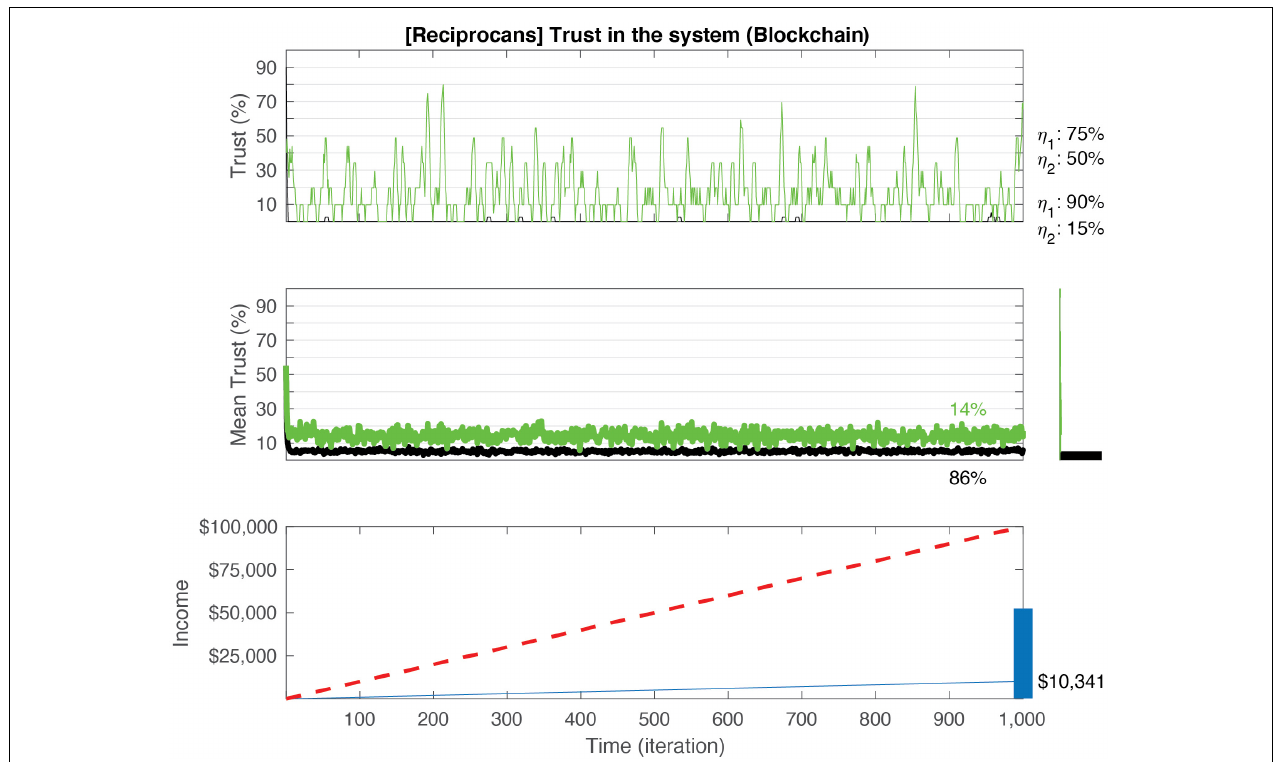
FIGURE 5 | Simulation of reciprocans Blockchain games with varying values of η 1 and η 2 . Top: depiction of two examples of games with η 1 >> η 2 and η 1 ≈ η 2 ratios. Middle: trust (see equation 2) decays in 86% of games to a value lower than the mean (7%), irrespective of the initial trust and the ratio between η 1 and η 2 (black line in the middle/top panels). Green (/black) line corresponds to the average of all trials that ended with trust values above (/below) the mean. A histogram of all final trust values is shown to the right. While high trust values have broader range, convergence to 0 trust is still dominant. This, however, has no effect on the individual/C-3PO income. Bottom: Blue line corresponds to the average cumulative sum in the games. The total cumulative sum generated by the C-3PO is $10,341. Red dashed line depicts the optimal (“Full trust”) revenue that the C-3PO can generate if all 1,000 trials were played with maximum payoff (1,000 × $100). The blue rectangle on the right axis corresponds to the upper/lower boundaries of income generated by the C-3PO, across all simulations. The values range between $256 and